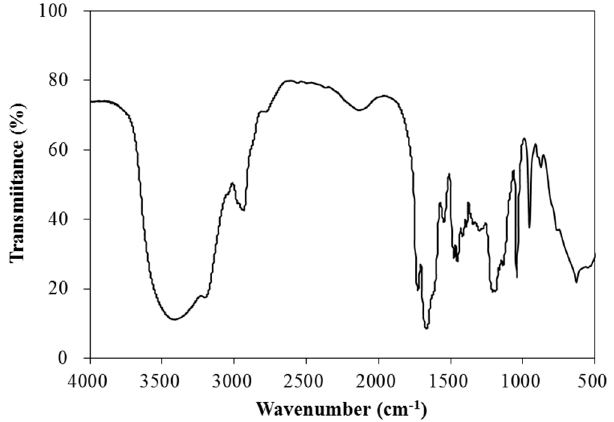
Figure 2. Analysis of SDCap Infrared spectrum.